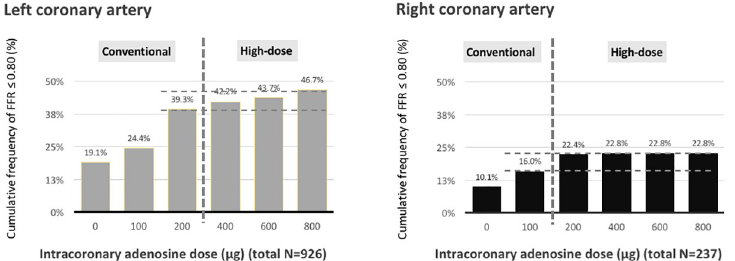
Fig 3. Frequency of vessels with FFR � 0.80 by adenosine dosage. The cumulative rate of FFR � 0.80 increased gradually (after the conventional dose) in the left coronary artery while high-dose escalating, whereas the cumulative rate plateaued after a 200 μ g adenosine injection in the right coronary artery. Bar: percentage of vessels recorded with FFR � 0.8 at this dose; solid line: cumulative percentage of vessels recorded FFR � 0.8 at this dose. Abbreviations: FFR: fractional flow